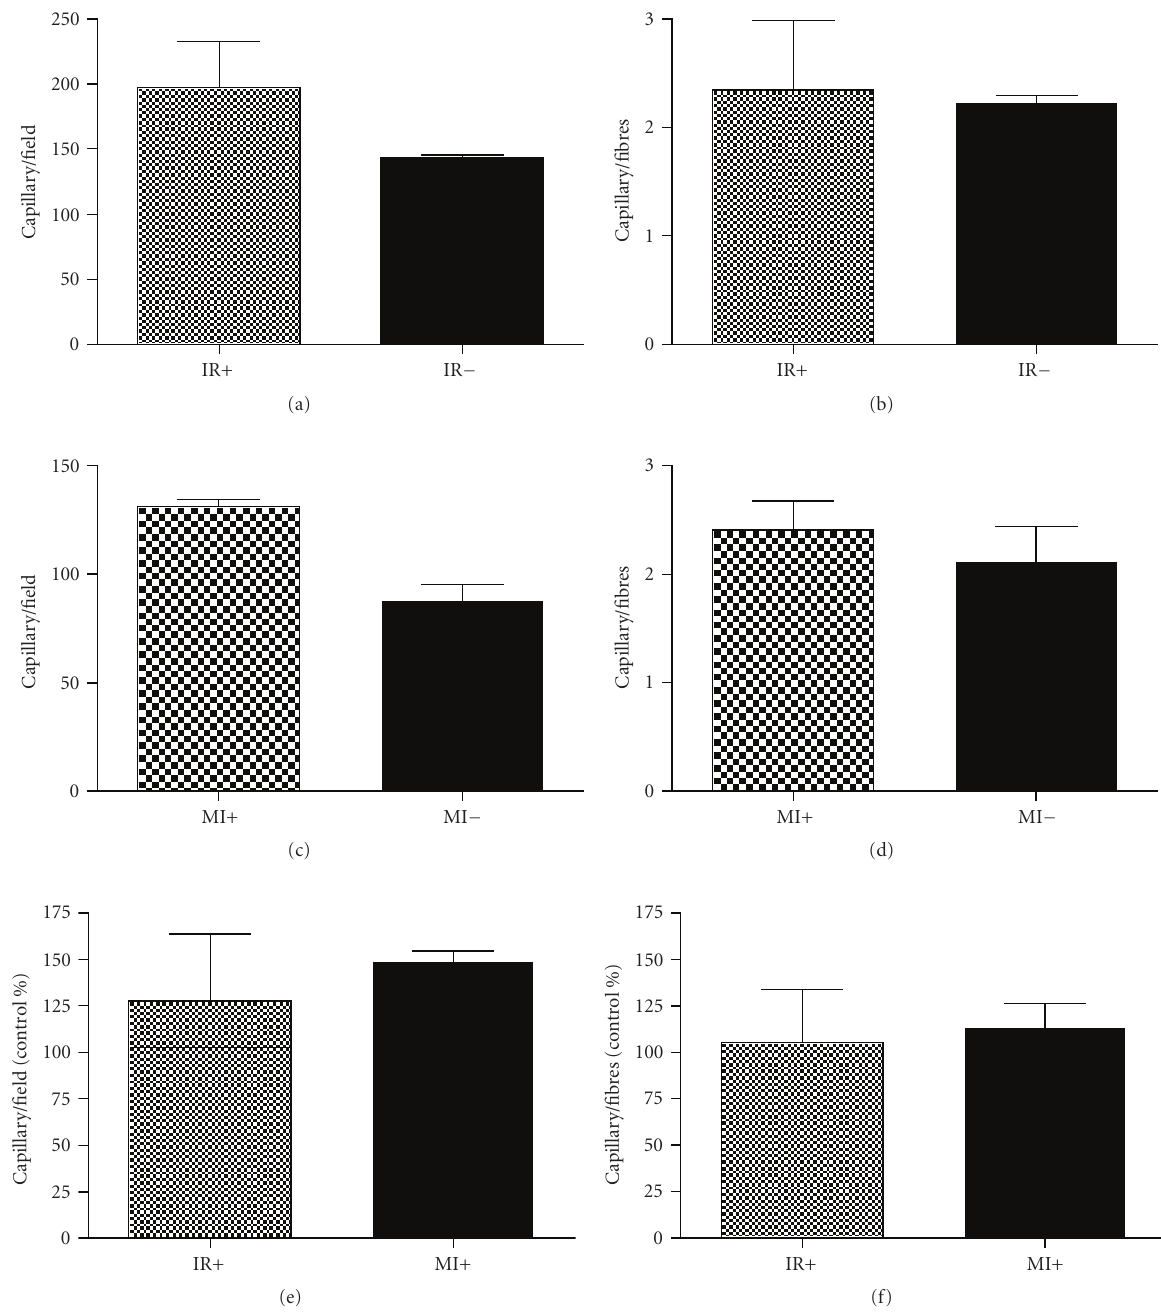
Figure 6: Capillary density 14 days after ischemia-reperfusion injury and myotoxic injury. Values are means ± SEM. Number of data per group is 3. IR+: ischaemic/reperfused muscles, IR − : control muscles of ischaemic/reperfused muscles, M+: myotoxin-treated muscles, M − : control muscles of myotoxin-treated